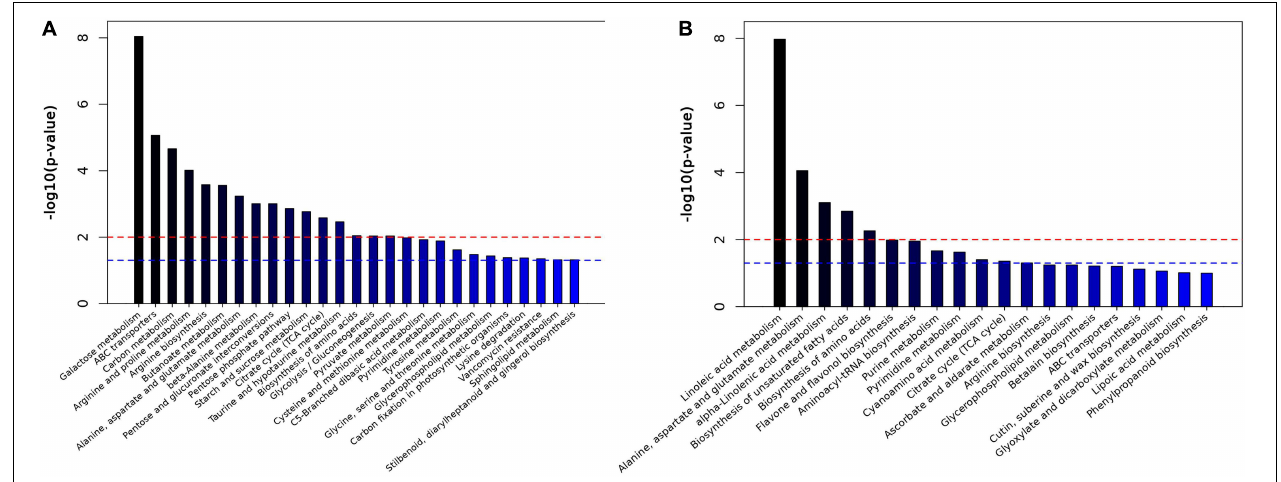
FIGURE 10 | Histogram of pathway analysis in GC-MS (A) and LC-MS (B) . The horizontal blue line indicated p < 0.05; the horizontal red line indicated p < 0.01 ( N =